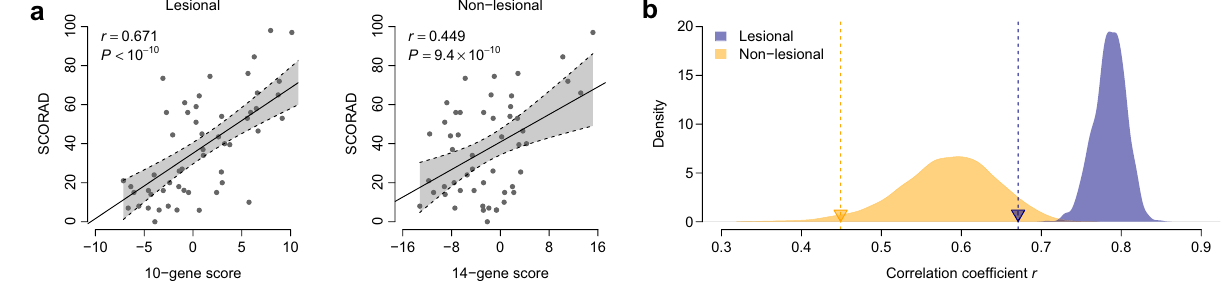
Figure 4. Comparison between the predictive power of the 36-gene signature and several published atopic dermatitis (AD) marker genes. ( a ) Correlation between SCORAD and severity scores computed for published marker genes. ( b ) Predictive power of our 36-gene signature compared with that of published AD marker genes. The navy- and orange-colored areas indicate the distribution of r for 1000 resampled gene signatures, randomly selected from our 36-gene signature, with a size identical to that of the published 10- and 14-gene signatures, respectively. The navy and orange triangles represent the r -values of the published 10- and 14-gene signatures,